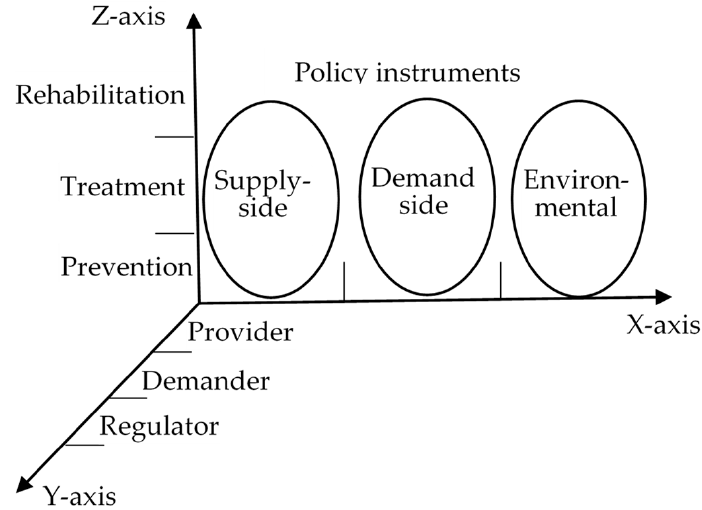
Figure 4. Three-dimensional analytical framework for integrated care Figure 4. Three ‐ dimensional analytical framework for integrated care policies.